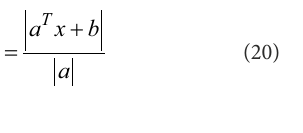
FIGURE 6 Support vector machine model diagram.